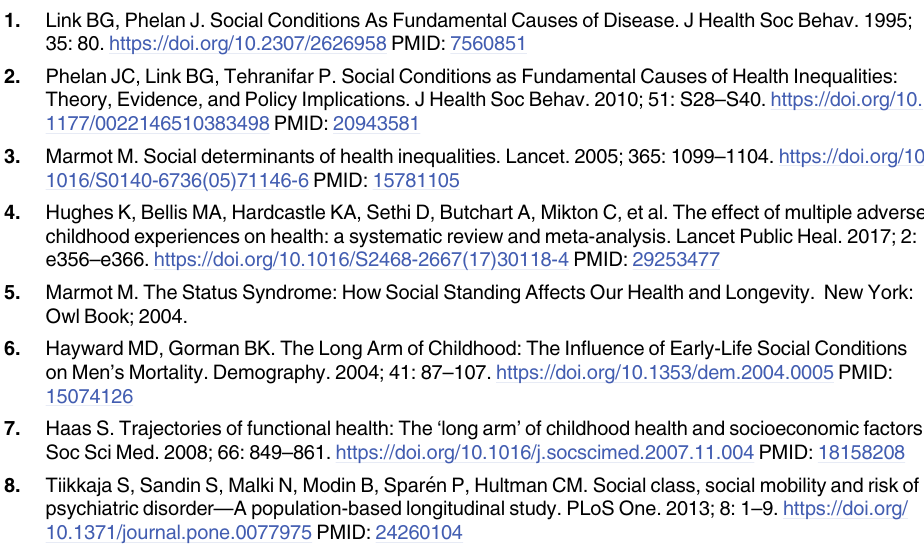
S9 Table. Point estimates from DRM on AL levels with socioeconomic tertiles and the sample of individuals with poor initial health at Wave I. Notes : � p < 0.05, �� p < 0.01, ��� p < 0.001, 95% confidence intervals in